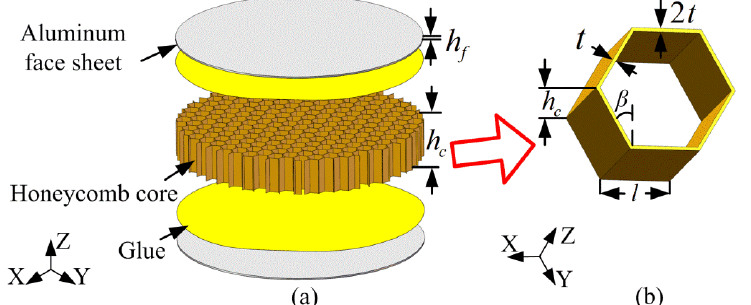
Figure 3. Diagrams showing the composition of a honeycomb sandwich structure: ( a ) the structure of the sandwich structure, and ( b ) a unit cell of the Nomex honeycomb.